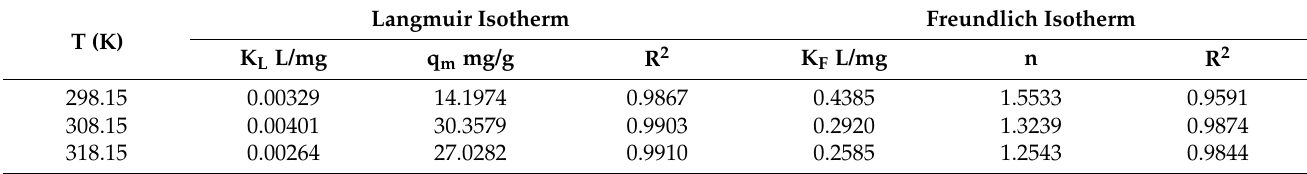
Table 4. T-BSA isothermal model fitting